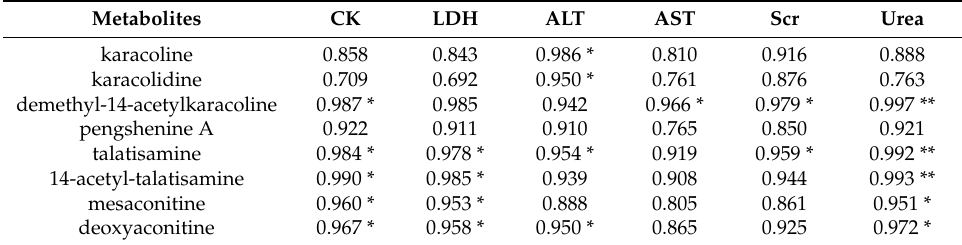
Figure 3. The variation trends of eight serum ingredients’ relative contents (peak area intensities) in different concentrations of Radix Aconiti ethanol extraction groups. A: 2 g/kg ethanol extraction; B: 5 g/kg ethanol extraction; C: 10 g/kg ethanol extraction. Table 2. The correlation of biochemical indicators and exogenous components.